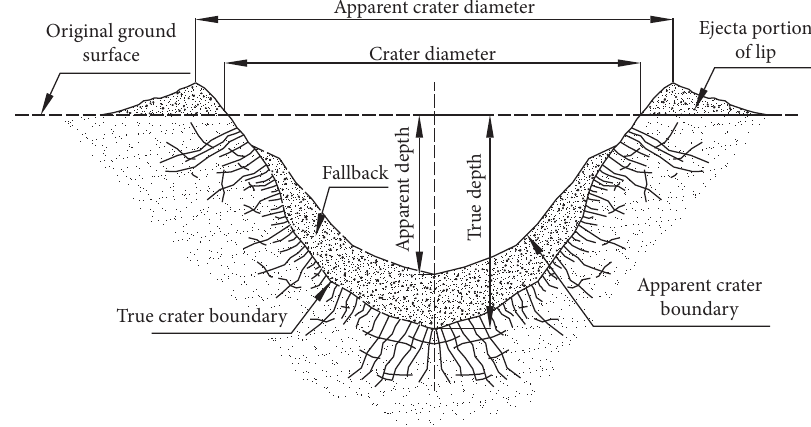
Figure 1: Typical profile of an explosion crater